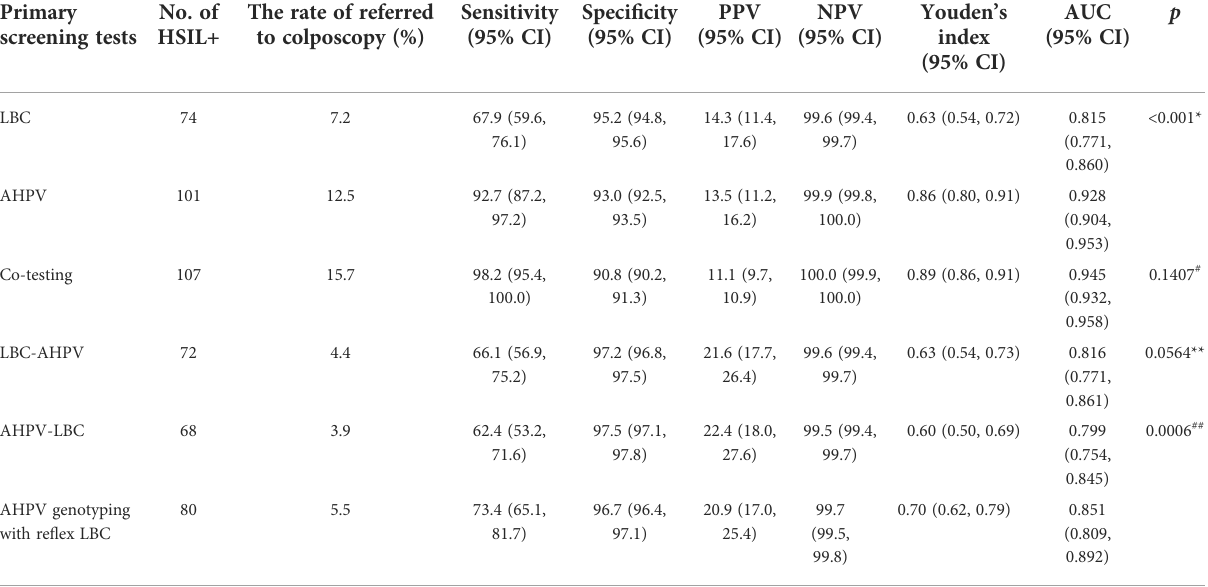
TABLE 3 Comparison of performance of different primary screening tests and different triage strategies. Primary No. of screening tests HSIL+